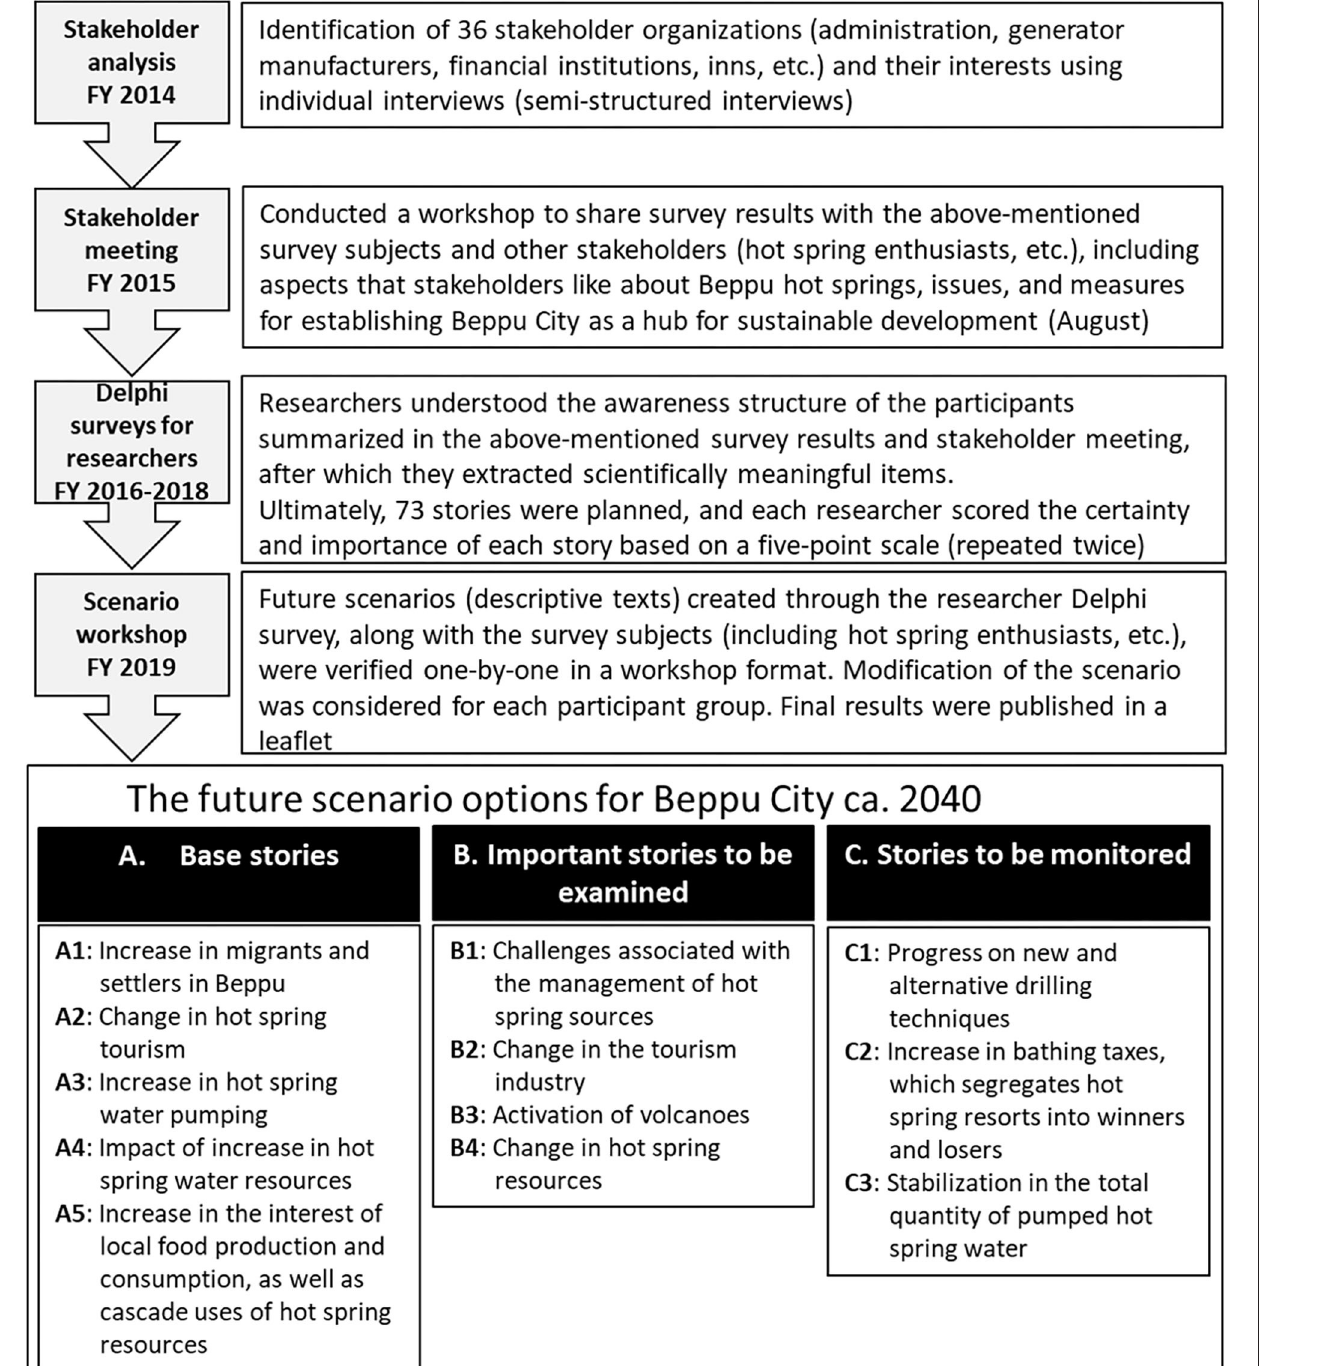
with experience in collecting scientific data on hot spring water using scientific instruments, including the temperature, electrical conductivity, pH, and dissolved chemical components,